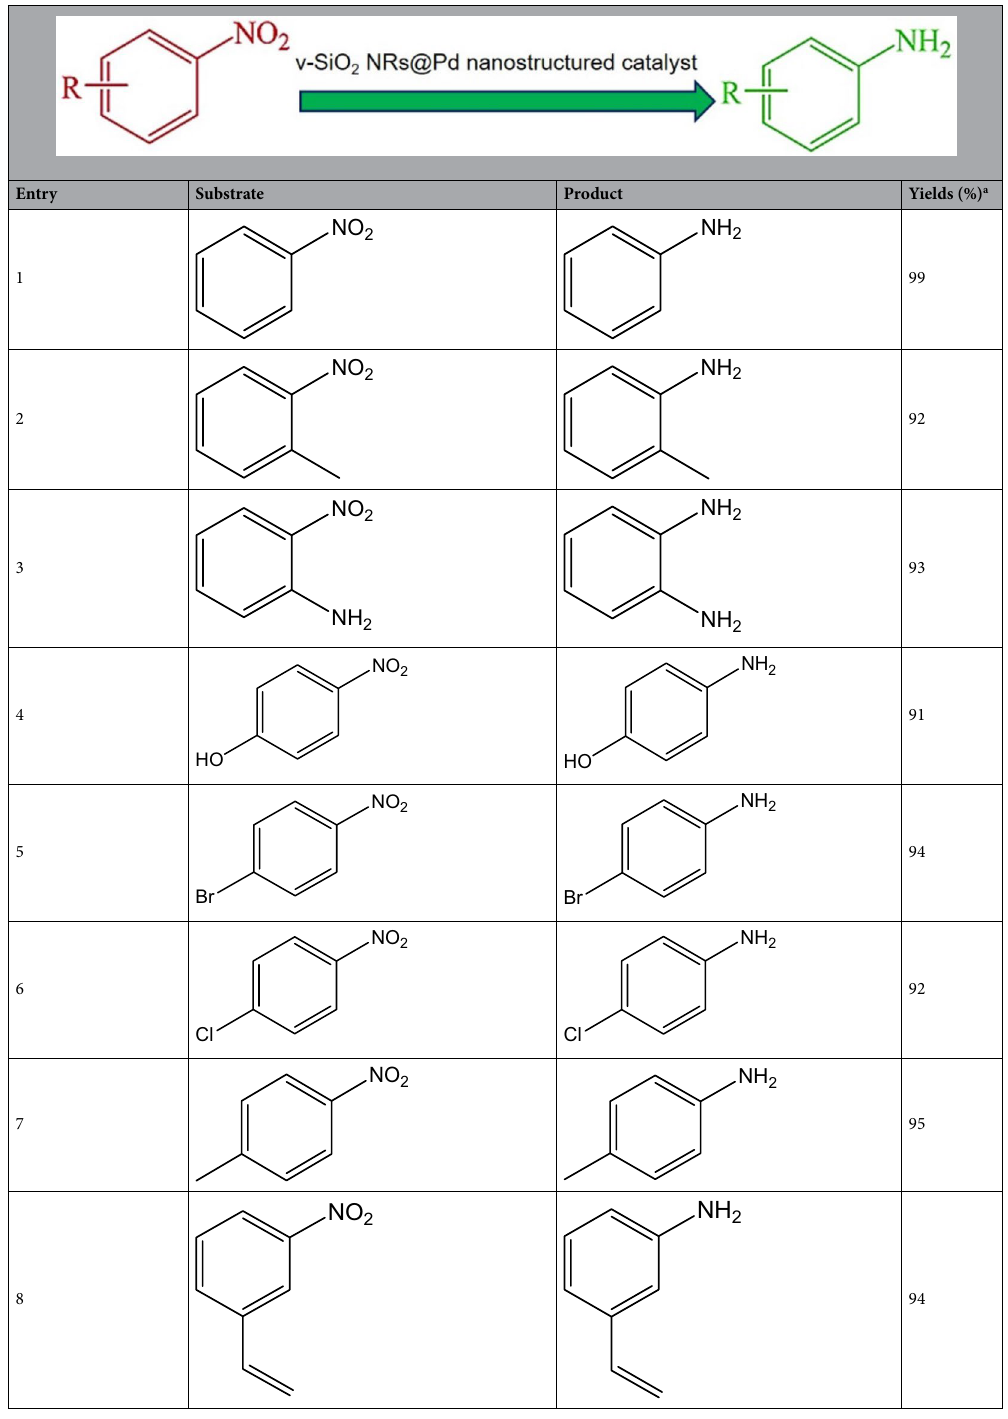
Table 1. Heterogeneous reduction of substituted nitroarenes catalyzed by v-SiO 2 NRs@Pd nanostructured catalyst. Reaction conditions: Substituted nitroarenes (0.1 mmol), NaBH 4 (0.12 mmol), v-SiO 2